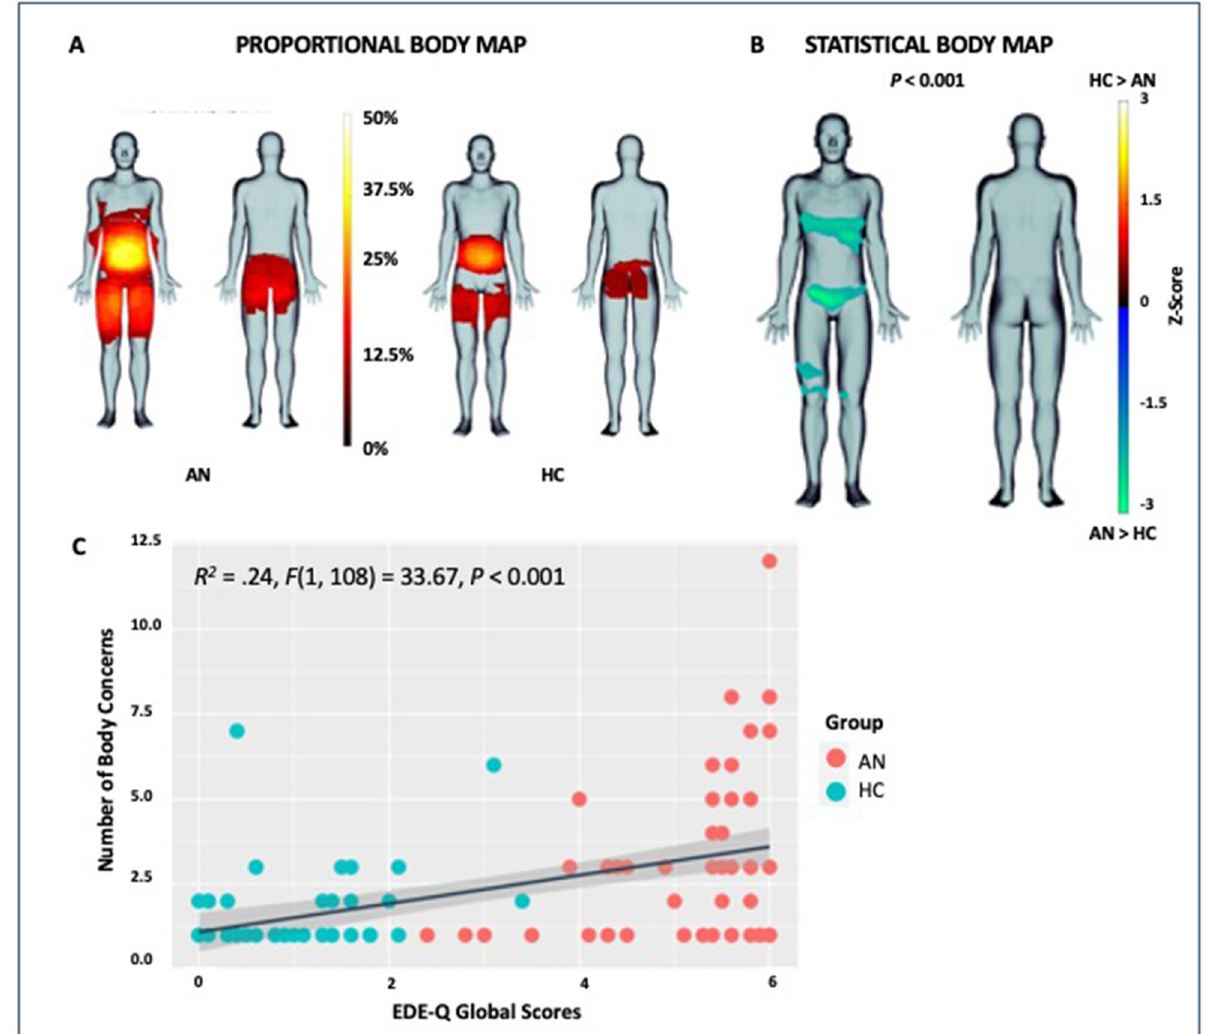
Figure 1. ( A ) (top left) Proportional body maps displaying the majority of body concern areas for each group (left anorexia nervosa (AN) group; middle healthy comparisons (HC)). ( B ) (top right) Statistical body map evaluating differences in body image concerns between AN group (in cool colors) and HCs (in warm colors; statistical threshold = P < 0.001); ( C ) (bottom) Association between Number of Body Concerns and Eating Disorder Symptomatology (EDE-Q Global Scores) across ANs and HCs ( P <